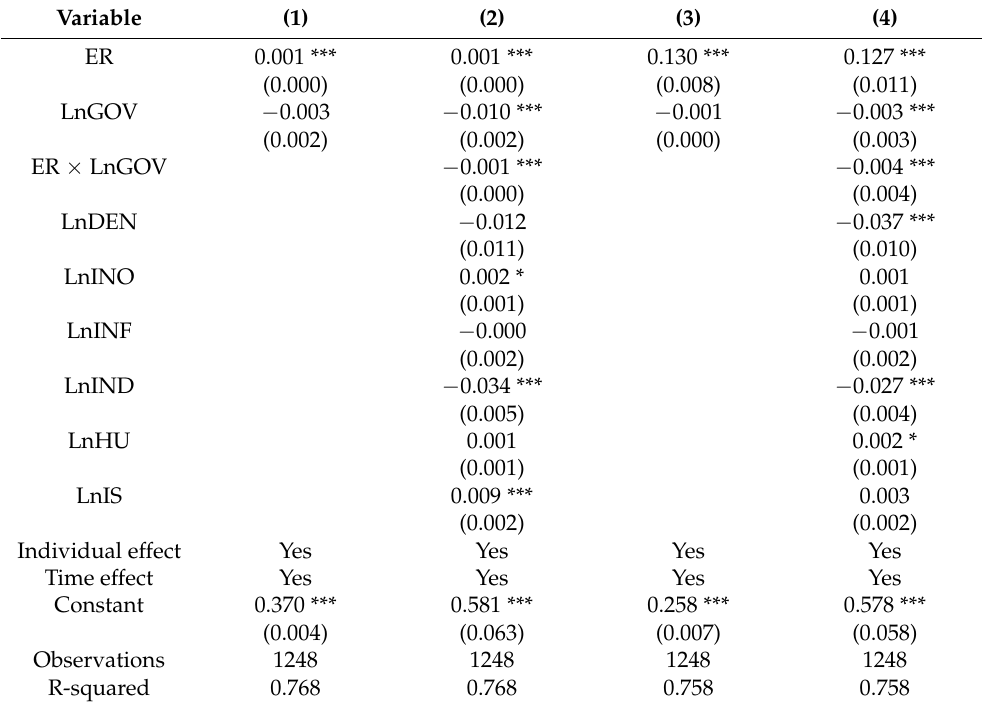
Table 8. Robustness test results: recalculating environmental regulation and local government competition